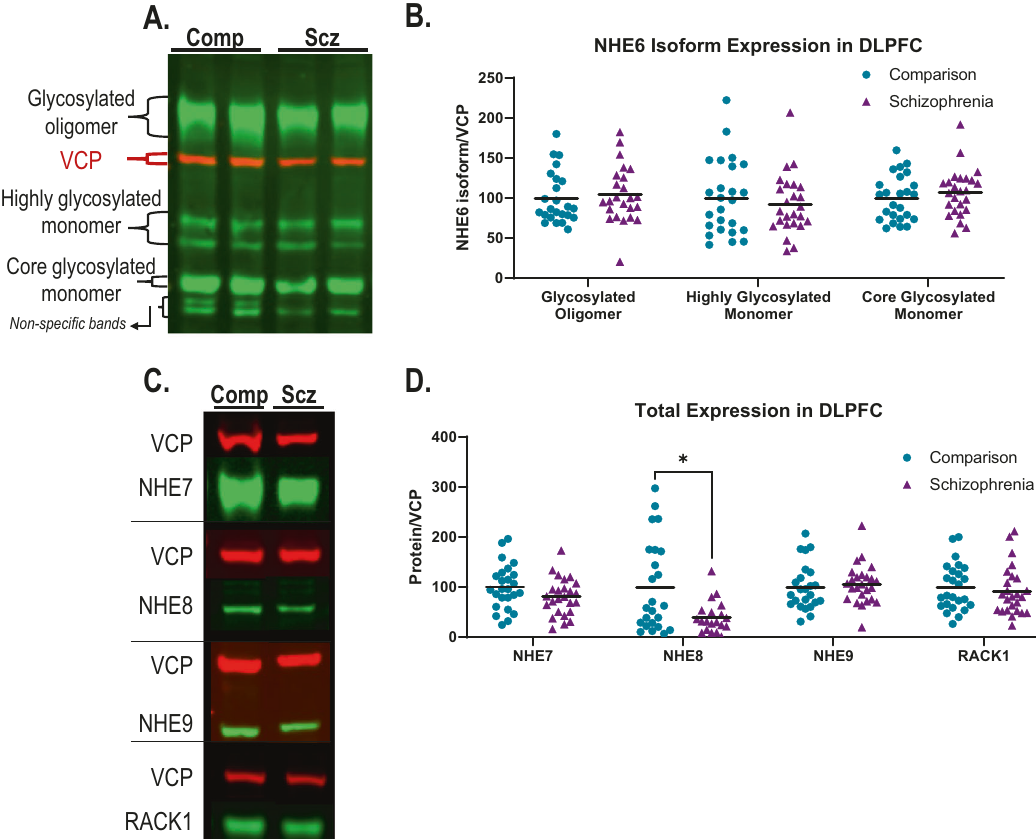
Fig. 2 Protein expression of NHE6-NHE9 and RACK1 in dorsolateral prefrontal cortex (DLPFC) as measured by Western blot in schizophrenia (SZ) and comparison (COMP) subjects. A Representative Western blot of NHE6 immunoreactive bands demonstrating three main isoforms: glycosylated oligomers, highly glycosylated monomers, and core glycosylated monomers. B Quanti fi cation of each NHE6 isoform normalized to intralane valosin-containing protein (VCP) did not reveal any difference in expression between SZ and COMP. C Representative Western blots of NHE7-NHE9 and RACK1 in SZ and COMP DLPFC. D Quanti fi cation of NHE7-NHE9 and RACK1 protein expression normalized to intralane VCP demonstrates a signi fi cant decrease in NHE8 expression in SZ DLPFC and no change in NHE7, NHE9, or RACK1 expression between groups. Lines represent group means. * p <